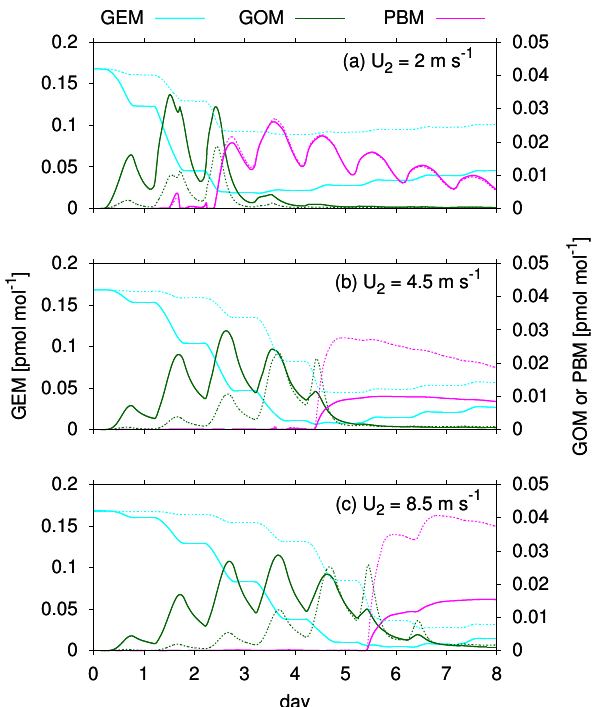
Fig. 7. Temporal evolution for the mixing ratios of GEM (light blue), GOM (dark green) and PBM (magenta) at the height of 1.5m in the ambient air from model runs at U 2 = 2 . 0 ms − 1 (a) , 4.5ms − 1 (b) , and 8.5ms − 1 (c) . Solid and dotted lines represent model runs with the gas-phase reaction HgBr+BrO switched on (scenario 1A) and off (scenario 1C), respectively.